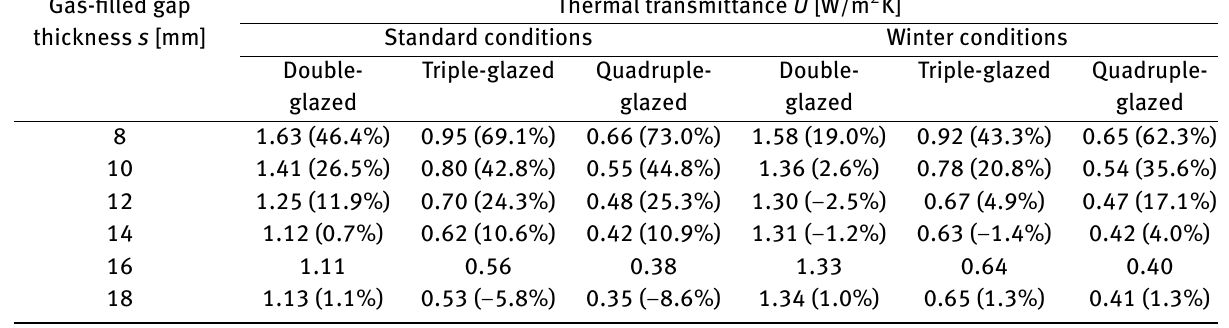
Figure 2: Structure of IGU: double-glazed unit, b) triple-glazed unit, a) quadruple-glazed unit. A - Component glass pane, B - Gas-filled gap, C - Low-E coating, D - Sealant, E - Edge spacer with moisture absorber. Table 1: Variations’ characteristics of heat transfer coeflcient of IGUs. Gas-filled gap